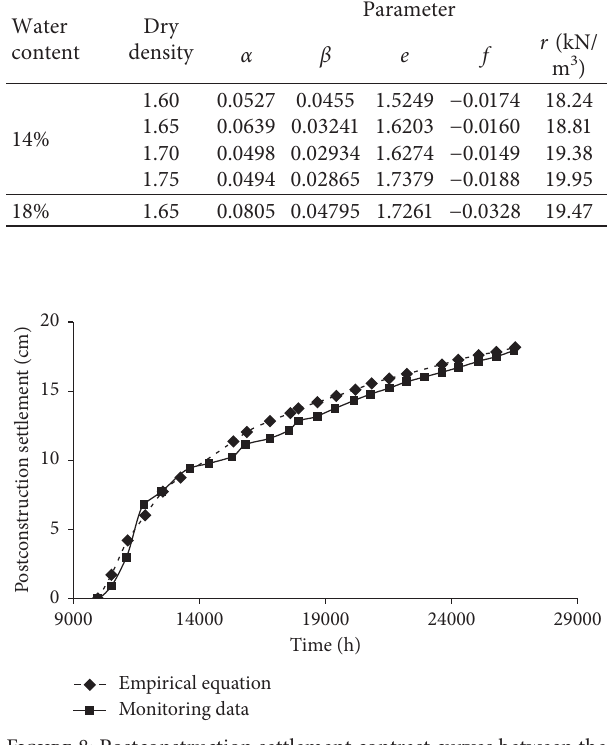
Figure 8: Postconstruction settlement contrast curves between the empirical equation and monitoring points JC01.